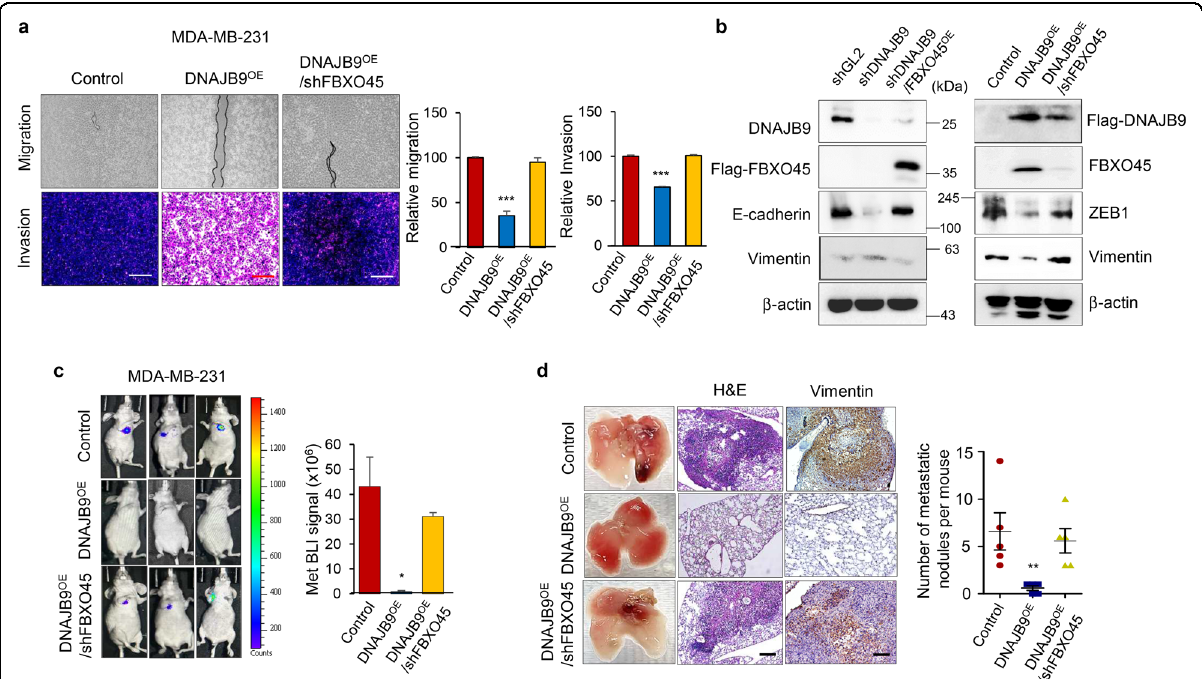
Fig. 5 DNAJB9 suppresses the metastasis of TNBC through FBXO45. a To measure the effect of DNAJB9 and FBXO45 on cell migration, cells were plated into six-well plates and wounded using pipette tips. After 24 h, the migrated cells were captured using a microscope and quanti fi ed using ImageJ. To measure the effect of DNAJB9 and FBXO45 on cell invasion, cells were plated into 8- μ m inserts. After 24 h, the invaded cells were stained with crystal violet, and signal intensity was measured using ImageJ. Results are presented as mean ± standard deviation from three independent experiments. Scale bar, 500 μ m. b Epithelial – mesenchymal transition markers were validated in MCF7-shDNAJB9 – FBXO45-OE and MDA- MB-231 – DNAJB9-OE – shFBXO45 cells using western blotting. A β -actin band was used as normalization control. c Representative images (left) and bioluminescence imaging signals (right) of lung metastasis after intravenous injection of the control, DNAJB9 OE or DNAJB9 OE/shFBXO45 cell lines (1 × 10 6 ) into 6-week-old female nude mice (5 mice in each group) 10 weeks post injection. The luciferase activity was detected using the IVIS Spectrum after injection of luciferin. d Representative images of metastatic lung tumors, hematoxylin and eosin (H&E), and human Vimentin immunohistochemical staining are shown (left), with the number of lung tumors derived from the indicated cell lines that were quantitatively analyzed (right). Scale bar, 200 μ m. Results are presented as mean ± standard deviation from three independent experiments. * p < 0.05; ** p < 0.01; *** p <